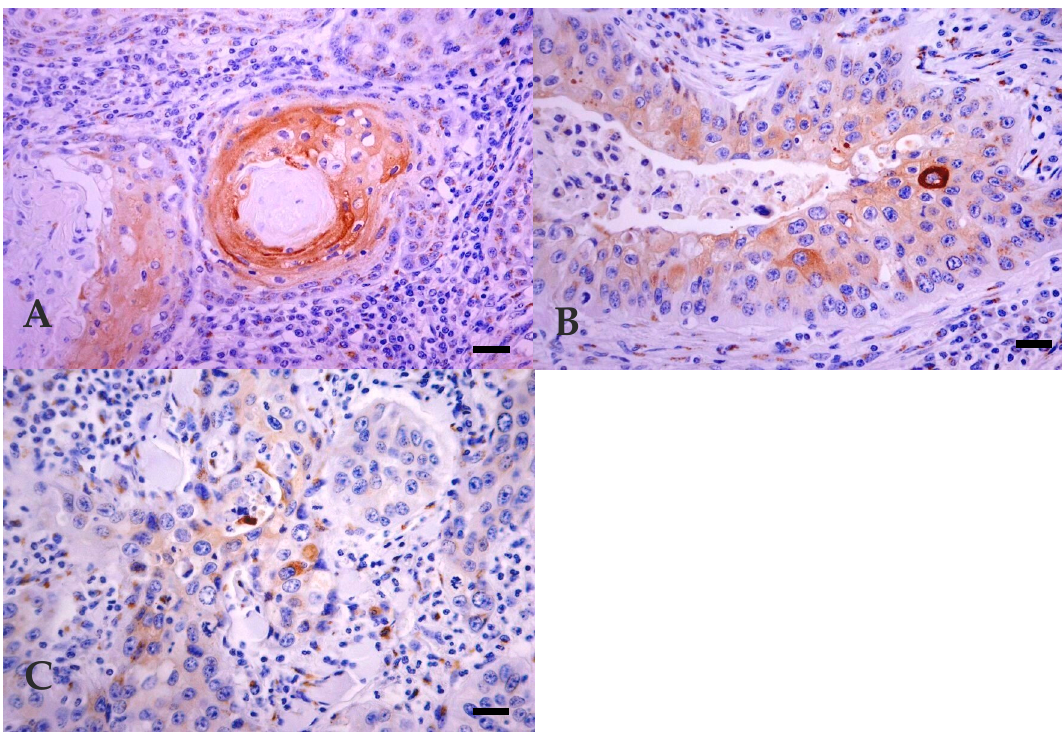
Figure 4. Expression of involucrin in BOSCC. ( A ) WD: cytoplasmic diffuse and intense Figure4. ExpressionofinvolucrininBOSCC.( A )WD:cytoplasmicdi ff useandintenseimmunoreactivity, immunoreactivity, seen mostly in well ‐ differentiated tumour cells. Bar, 25 μ m. ( B ) MD: cytoplasmic seen mostly in well-di ff erentiated tumour cells. Bar, 25 µ m. ( B ) MD: cytoplasmic di ff use and intense reaction, only in a limited number of well-di ff erentiated tumour cells but also in dysqueratotic and diffuse and intense reaction, only in a limited number of well ‐ differentiated tumour cells but also in acantolytic cells. Bar, 25 µ m. ( C ) PD: cytoplasmic di ff use and intense reaction, only in a limited number dysqueratotic and acantolytic cells. Bar, 25 μ m. ( C ) PD: cytoplasmic diffuse and intense reaction, only of well-di ff erentiated tumour cells. Bar, 25 µ m. Immunohistochemistry using avidin-biotin complex in a limited number of well ‐ differentiated tumour cells. Bar, 25 μ m. Immunohistochemistry using method, Mayer’s Hematoxylin avidin ‐ biotin complex method, Mayer’s Hematoxylin counterstain.